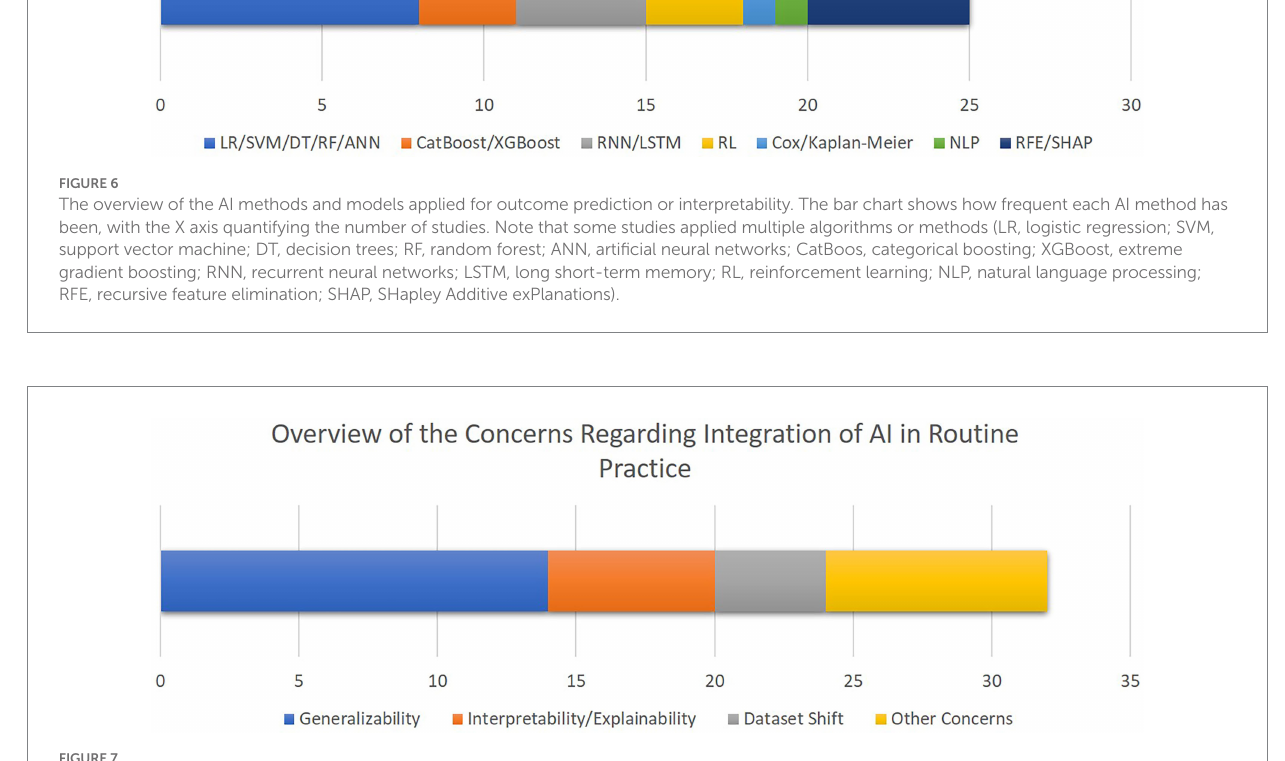
FIGURE 7 The overview of the concerns towards integration of AI-driven decision support tools in clinical routines as discussed in the selected studies. The bar chart shows how frequent each concern has been, with the X axis quantifying the number of studies. Note that some studies mentioned multiple